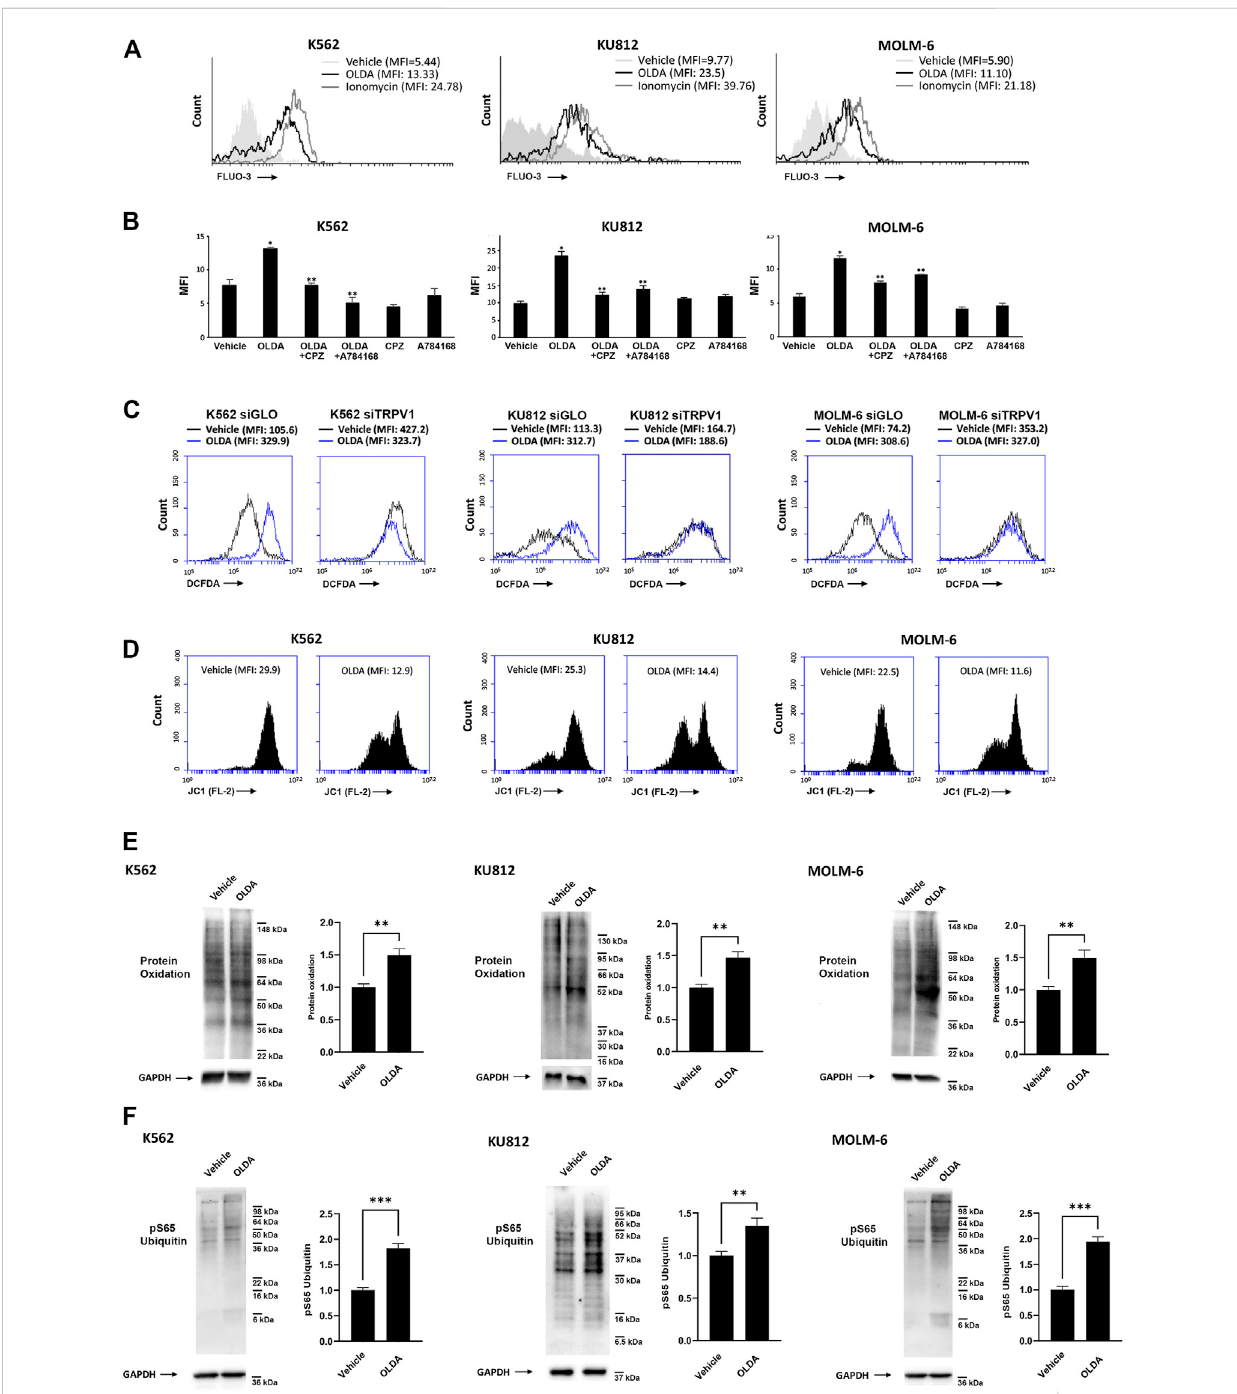
FIGURE 2 Triggering of TRPV1 stimulates [Ca 2+ ] i and oxidative stress in CML cells. (A) [Ca 2+ ] i evaluated by Fluo-3 staining and fl ow cytometric analysis in CML cellstreatedfor1 minwithOLDA(IC 50 dose).MFI,mean fl uorescenceintensity. (B) [Ca 2+ ] i assessedbyFluo-3stainingand fl owcytometricanalysisinCML cells pretreated withCPZ orA784168for 3 min before theadditionofOLDAfor 1 min.Data are themean ± SDofthree experiments.* p < 0.05 vsvehicle; ** p < 0.05vsOLDA-treatedcells. (C) ROSwereinvestigatedbyDCFDA stainingand fl owcytometricanalysisinsiGLOandsiTRPV1 CMLcellstreated withthevehicleorOLDA(IC 50 dose)for6 h.MFI,mean fl uorescenceintensity.Dataarerepresentativeofoneoutofthreeseparateexperiments. (D) ΔΨ m changesinOLDA-treatedCMLcellsbyJC-1stainingand fl owcytometricanalysis.Dropin Δ Ψ mdecreasestheJ-aggregate(red fl uorescence).MFI,mean fl uorescence intensity. Data are representative of three experiments. (E, F) Western blot analysis was performed on lysates from CML cells treated with OLDA or the vehicle for 24 h to investigate proteinoxidation (E) and pSer65 ubiquitin (F) . Blotsare representative of three experiments.GAPDH wasused as the loading control. Folds (mean ± SD of three experiments) = changes compared to the vehicle. ** p < 0.01; *** p <